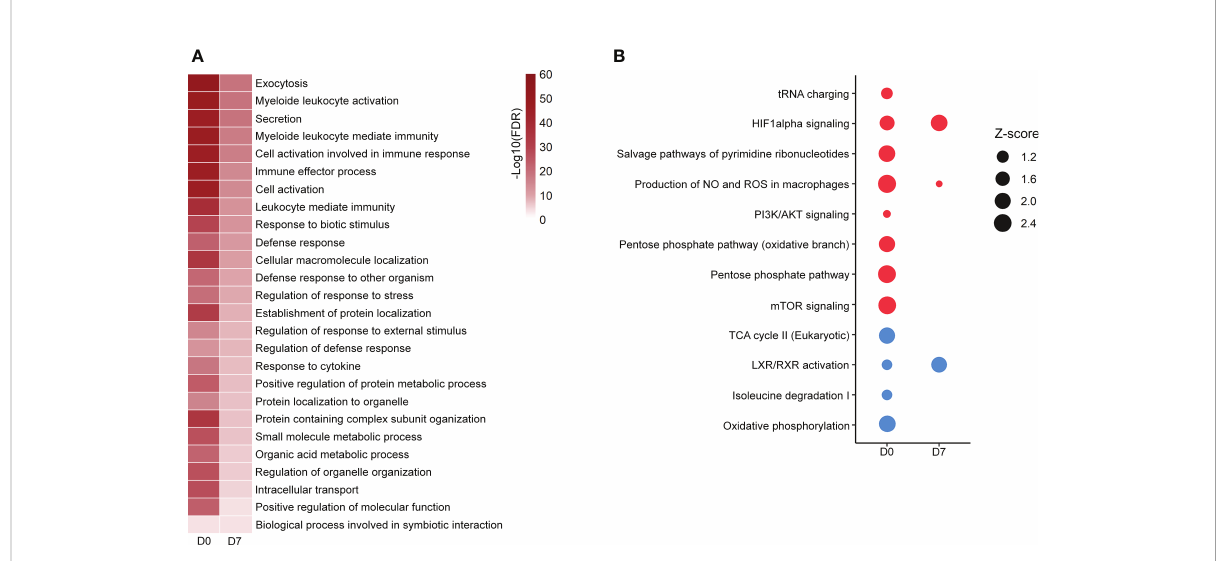
FIGURE 1 Altered pathways in septic patient ’ s proteome ad D0 and D7. (A) : Gene ontology biological processes signi fi cantly enriched at D0 and D7. Color scale represents -Log 10 (FDR). (B) : metabolism-targeted IPA analysis. All selected pathways presented B – H p-value <0.05. Dots size represents the z score, which predicts the activation (red dots) or inhibition (blue dots) of a given pathway. Proteomic data from patients at D0 were obtained from